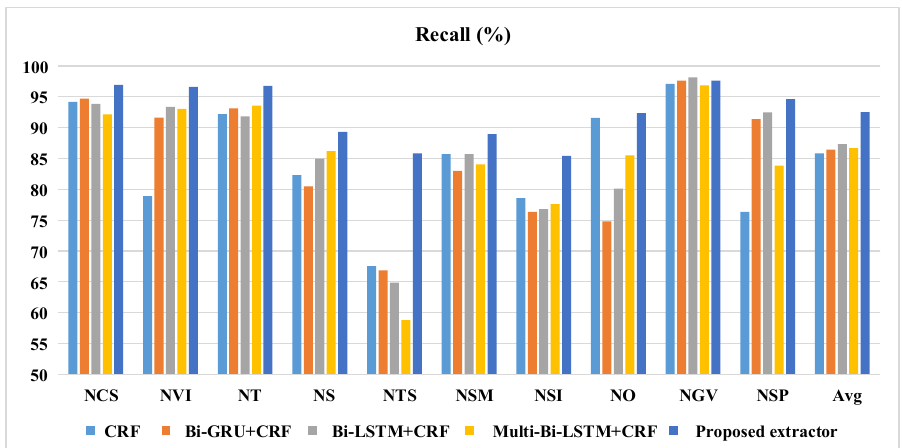
Figure 7. Recall performance of the deep learning-driven extractor and baselines in each category.